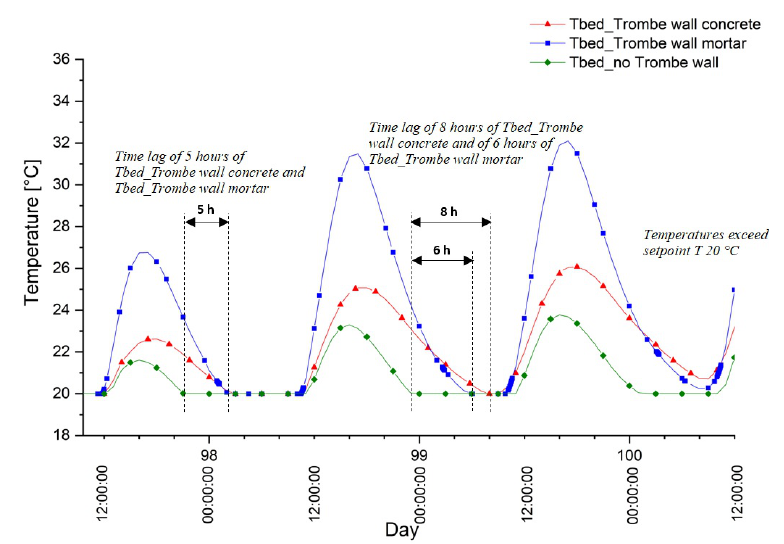
Figure 12. Time lags to recover heating inside bedrooms equipped with the composite Trombe wall vs. the reference case.